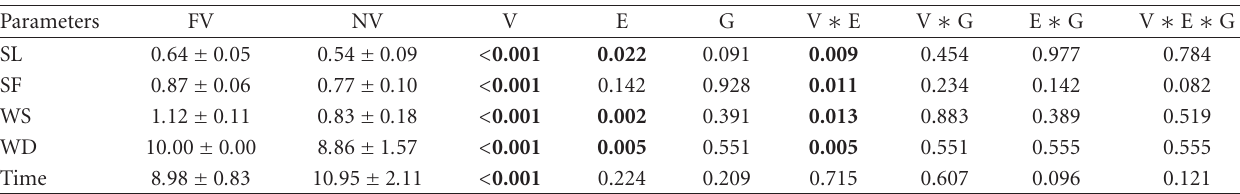
Table 1: Mean ± standard deviation of gait spatio-temporal parameters in full (FV) versus no vision (NV) condition, and the P values of the e ff ects of vision (V), environment (E), gender (G), and all their possible interactions on step length (SL), step frequency (SF), walking speed (WS), walked distance (WD), and walked time (Time).